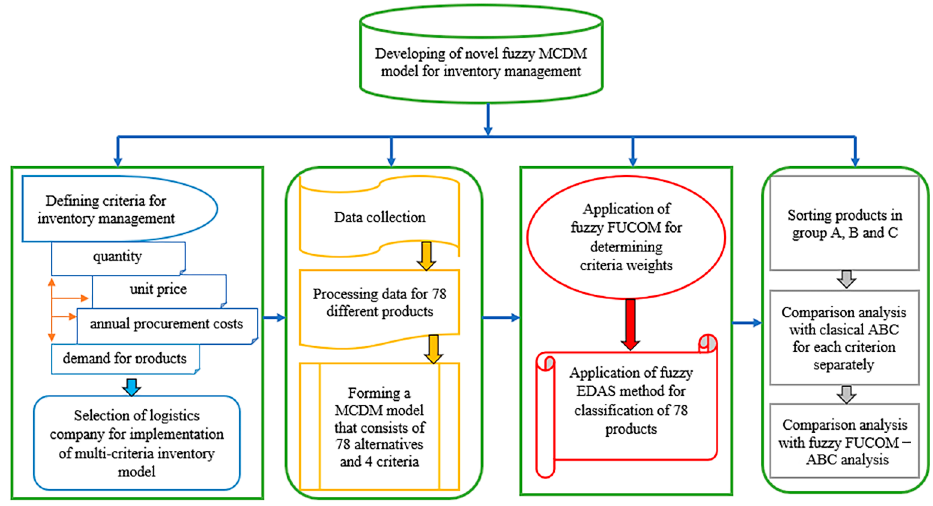
Figure 1. Research flow for inventory